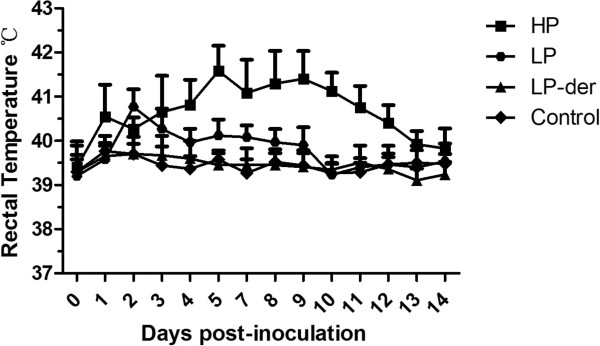
Rectal temperature changes in pigs at 0 to 15 days post-inoculation of highly pathogenic PRRSV strain BB0907 (HP), low pathogenic PRRSV strain NT0801 (LP), NT0801 derivative strain NT0801-F70 (LP-der; propagated in MARC-145 cells to 70 passages), and Dulbecco’s modified Eagle’s medium (DMEM) (Control). Each data point represents the mean ± standard deviation (SD) generated from 6 pigs in each group.